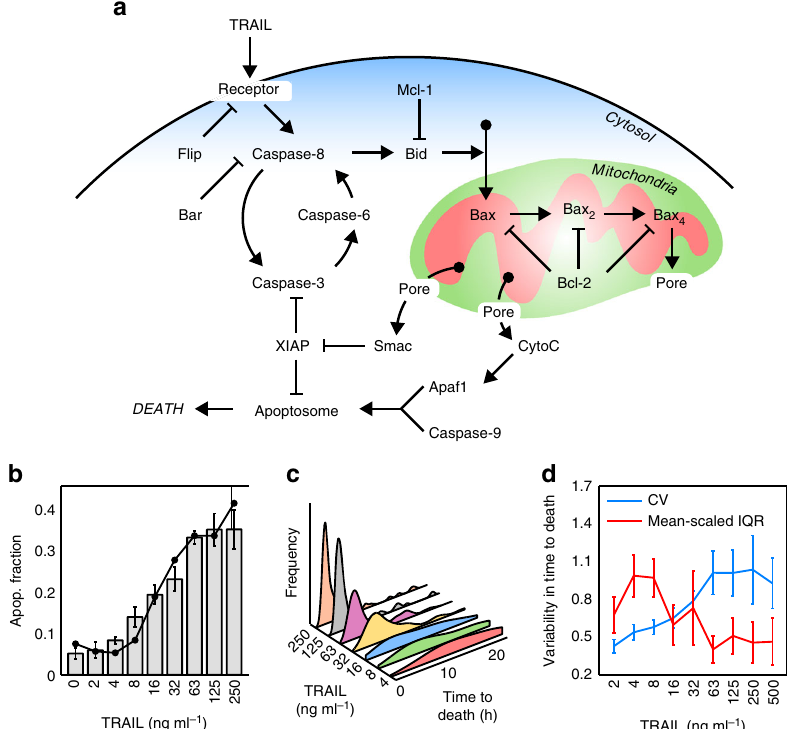
Fig. 1 Apoptotic variability in fate and time to death of HeLa cells exposed to TRAIL. a Cartoon of the main protein network of the extrinsic apoptotic pathway. CytoC cytochrome C; Pore, mitochondrial membrane permeabilisation (MOMP); Bax 2,4 , activation and oligomerisation process of Bax to form the mitochondrial pore. b Apoptotic fraction of HeLa cells after 24 h of TRAIL treatment (0, 2, 4, 8, 16, 32, 63, 125, 250 ng ml − 1 ). Apoptotic cells were quanti fi ed by visual inspection of phase contrast images (grey bars) and by FACS using Annexin V (FITC)-PI double staining (black dots). Around 300 cells for each TRAIL dose were inspected to obtain the apoptotic fraction. Error bars are standard deviation of three independent experiments. Data are representative of three independent experiments c Distributions of times to death after TRAIL treatment. Times to death were obtained by tracking cells in 24-h time-lapse experiments. Between 100 and 200 cells were analysed at each TRAIL dose to obtain the distributions. d Analysis of the variability in time to death at different TRAIL doses using two different statistical measures: the coef fi cient of variation (CV, blue) and the mean-scaled interquartile range (IQR, red). Error bars are computed by